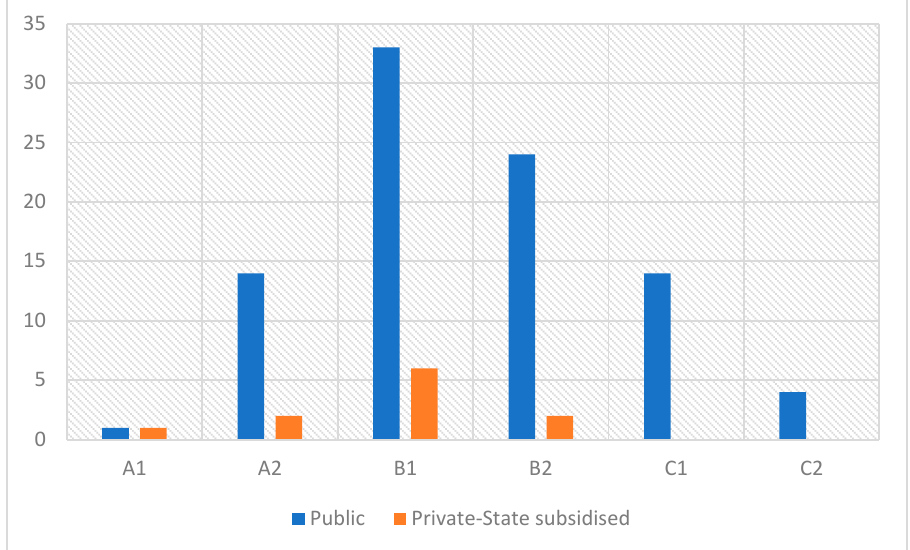
Figure 6. Level of Digital Competence by type of Educational Establishment.